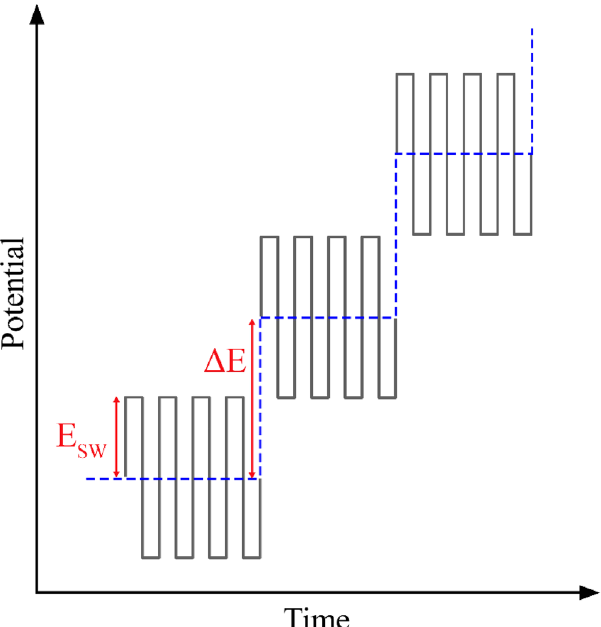
Figure 4. Applied potential waveform during FFT-SWV